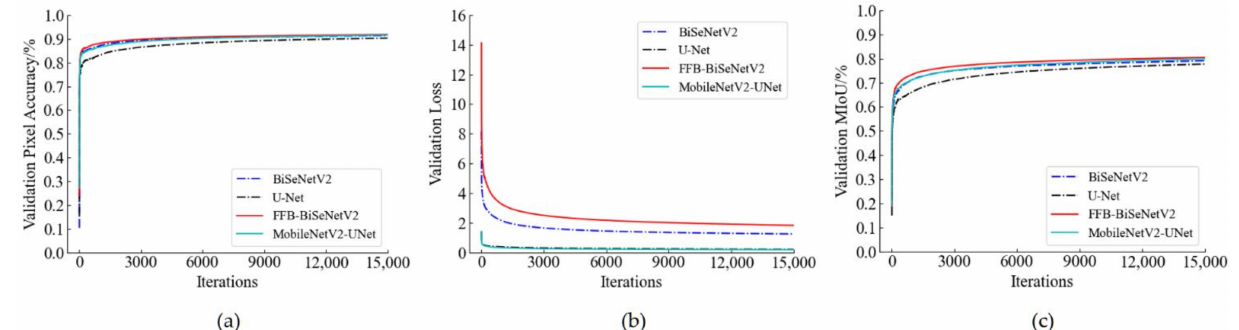
Figure 9. Changes of pixel accuracy, loss value and MIoU in the validation set. ( a ) Changes of the pixel accuracy; ( b ) Changes of the loss value; ( c ) Changes of the MIoU in the validation